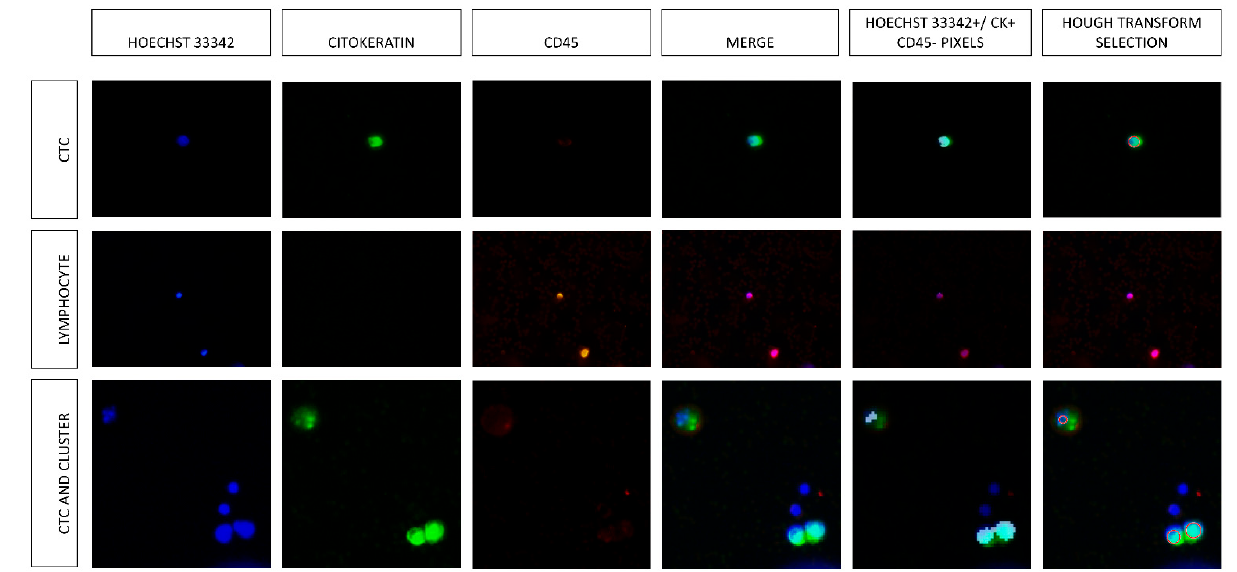
Figure 1. Row one shows the CTC staining characterized by Hoechst 33342+/CK+/CD45-. The fifth image in the first row shows the selection of pixels with CTC staining, and the last photo shows a CTC surrounded by a red circumference counted by the Hough transform. Row two shows the staining of some lymphocytes. Row three shows a free-CTC and a cluster consisting of two cells. Columns five and six show that the Hough transform algorithm did not count the CTCs if the element had no CK staining. Table 1. Total counted PCCs with the Manual-Isoflux TM System and Hough-Isoflux TM System. Data are presented with the mean and